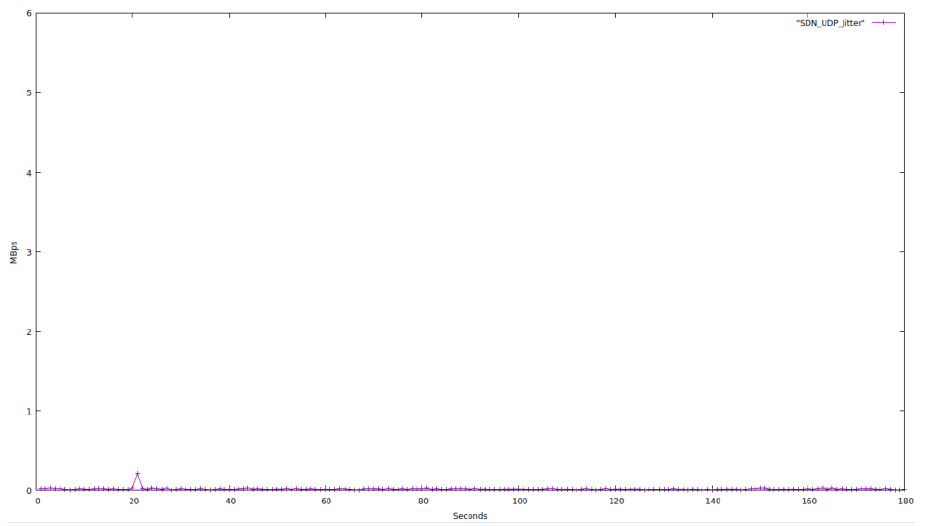
Figure 11. Jitter variation in SDN.